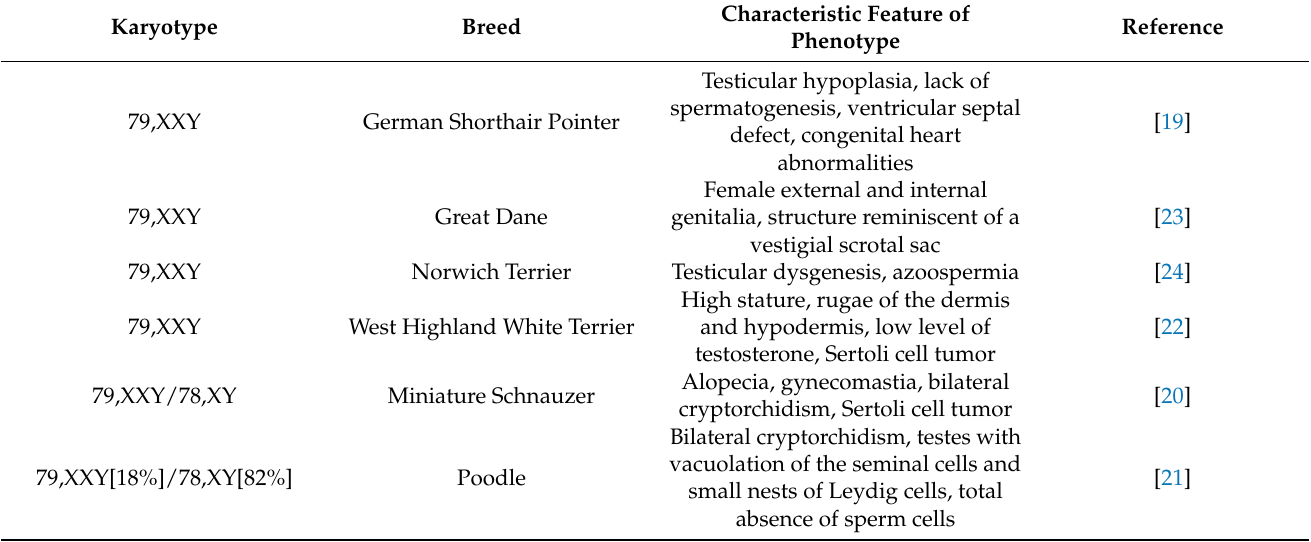
Table 3. Cases of the XXY complement reported in